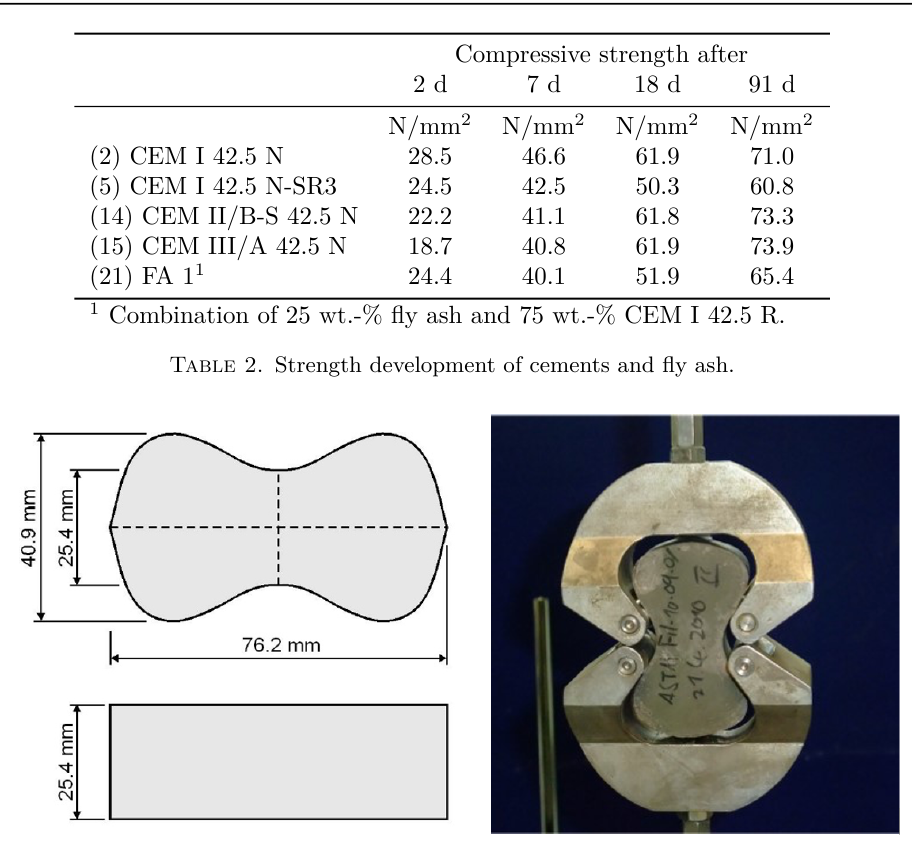
Figure 1. Concrete test specimens acc. to ASTM